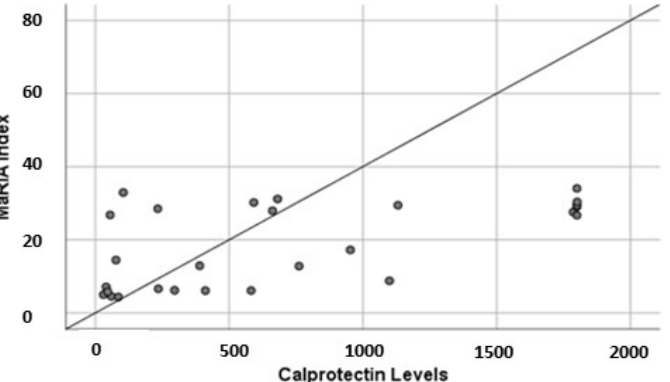
Figure 4. Correlation between fecal calprotectin levels and lesions at magnetic resonance enterogra- phy (MaRIA Index).